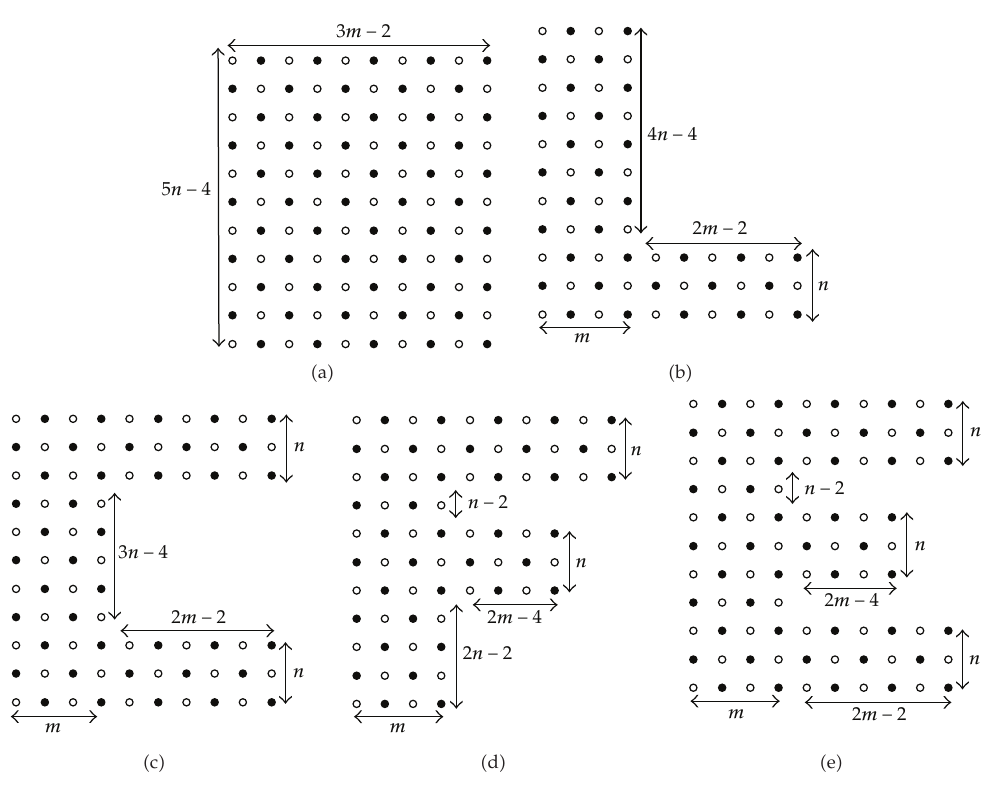
Figure 1: (cid:6) a (cid:7) A rectangular grid graph R (cid:6) 10 , 11 (cid:7) , (cid:6) b (cid:7) an L -alphabet grid graph L (cid:6) 4 , 3 (cid:7) , (cid:6) c (cid:7) an C -alphabet grid graph C (cid:6) 4 , 3 (cid:7) , (cid:6) d (cid:7) an F -alphabet grid graph F (cid:6) 4 , 3 (cid:7) , (cid:6) e (cid:7) an E -alphabet grid graph E (cid:6) 4 , 3 (cid:7) .